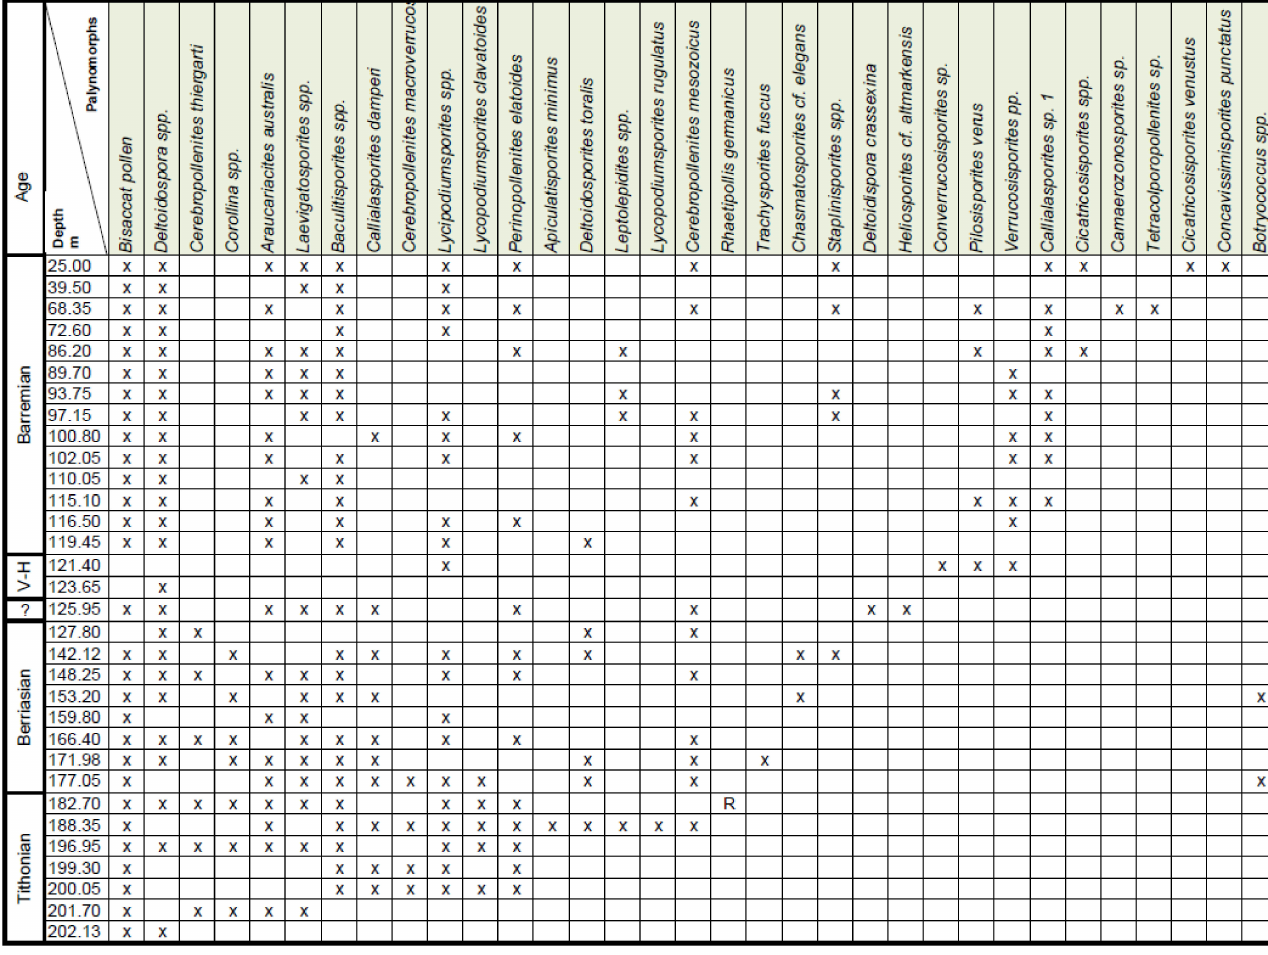
Figure A3. Records of terrestrial palynomorphs in borehole Bh